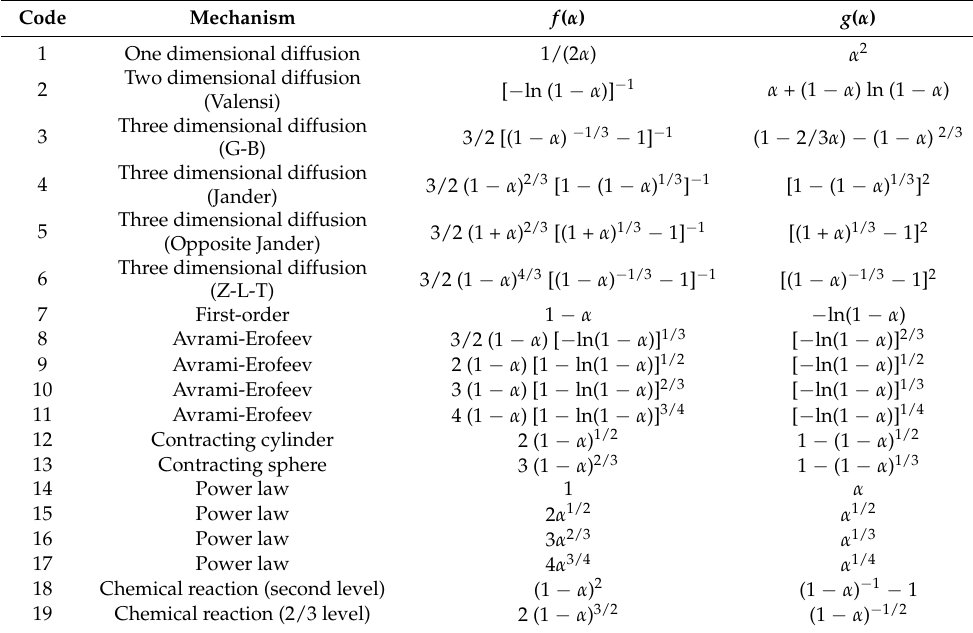
Table 3. 19 probable mechanism